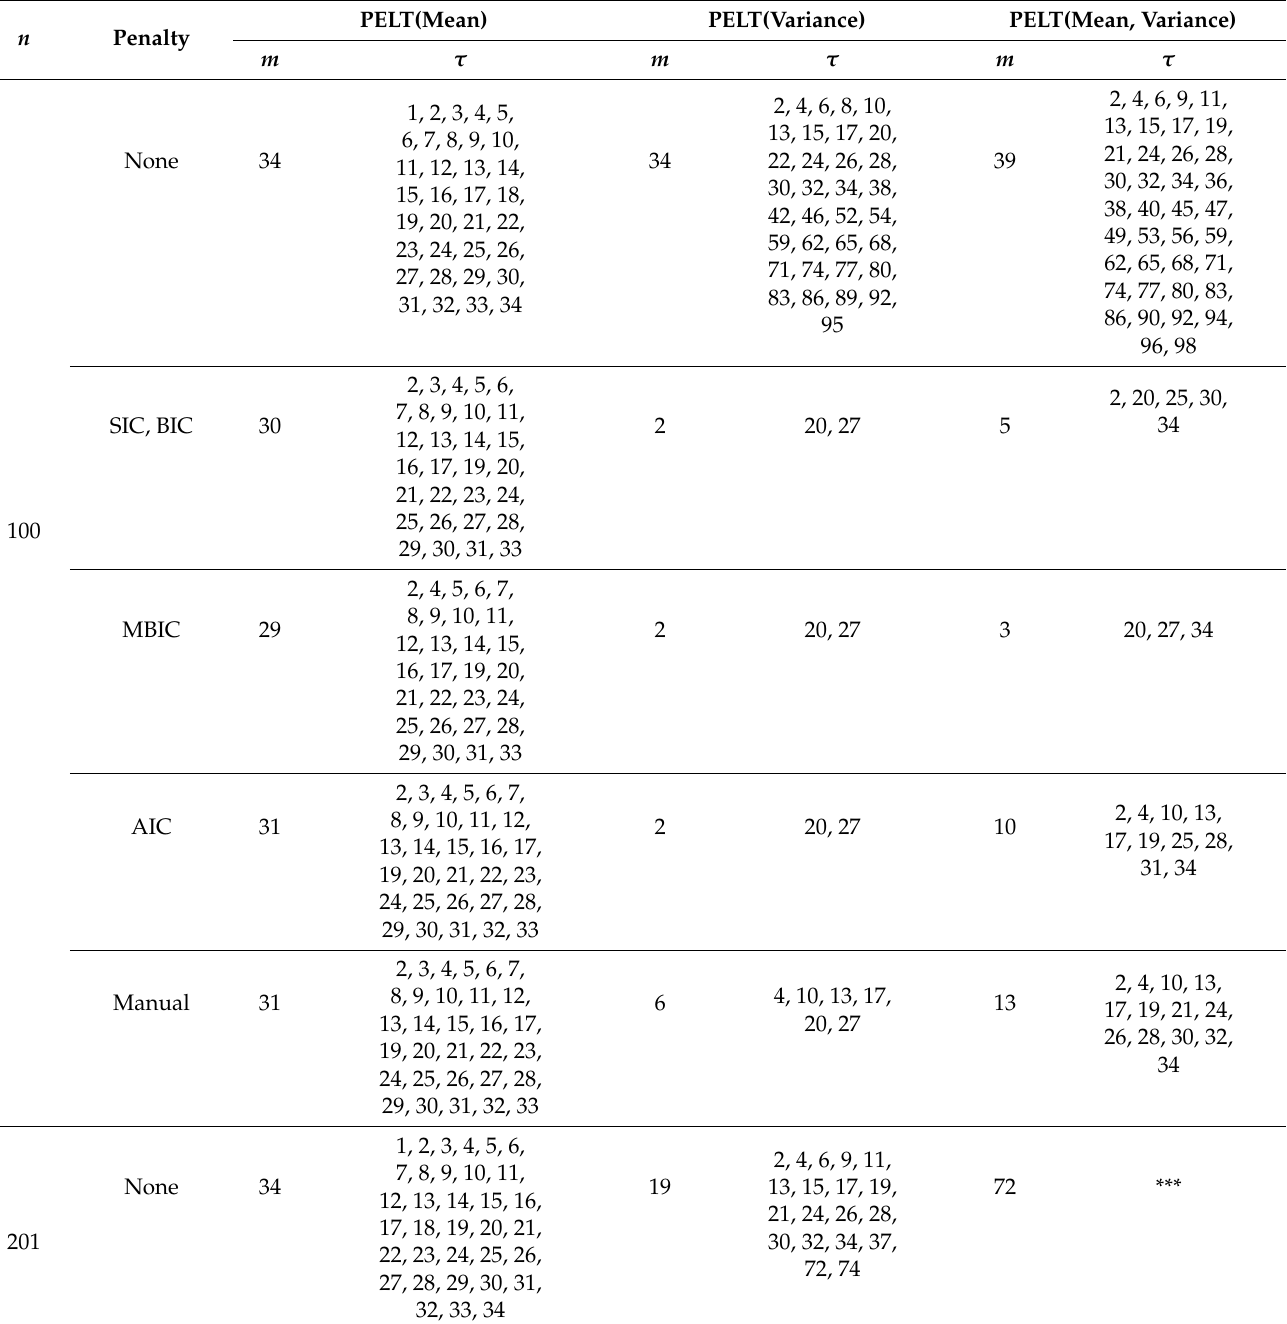
Table A5. PELT Algorithm Result for Simulated